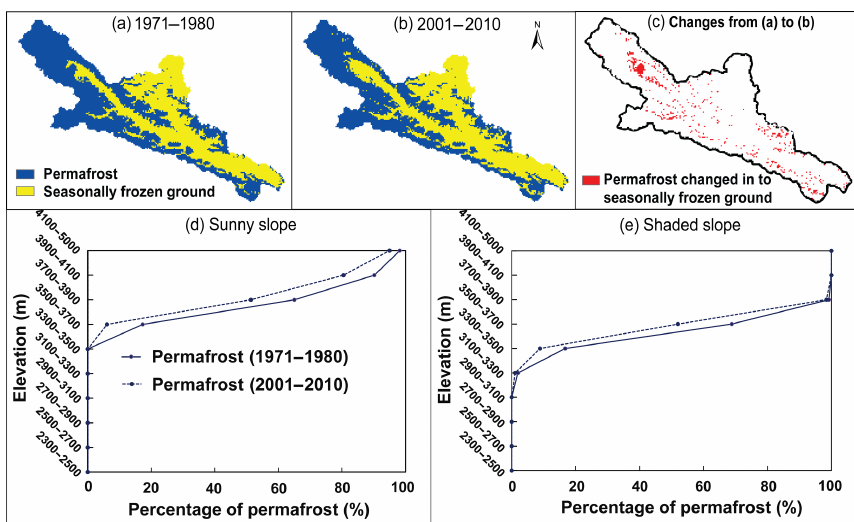
Figure 9. Distribution of permafrost and seasonally frozen ground for two periods: (a) 1971–1980 and (b) 2001–2010; (c) area where permafrost degraded to seasonally frozen ground from (a) to (b) ; percentage of permafrost area with respect to elevation on the (d) sunny and (e) the shaded slopes for the two periods. Note that (d) and (e) share a legend.